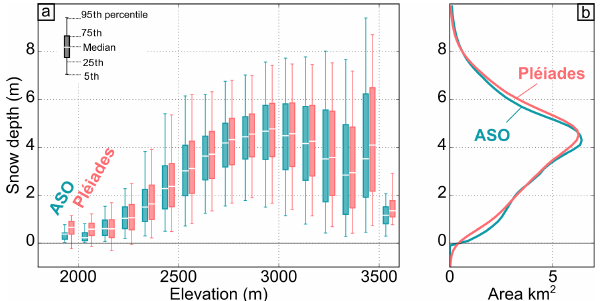
Figure 6. Snow depth against elevation (a) and total distribution (b) from Pléiades data (pink) and ASO (blue). The box plots show the median value (white line), the 25th and 75th percentile (box), and the 5th and 95th percentile (whiskers).